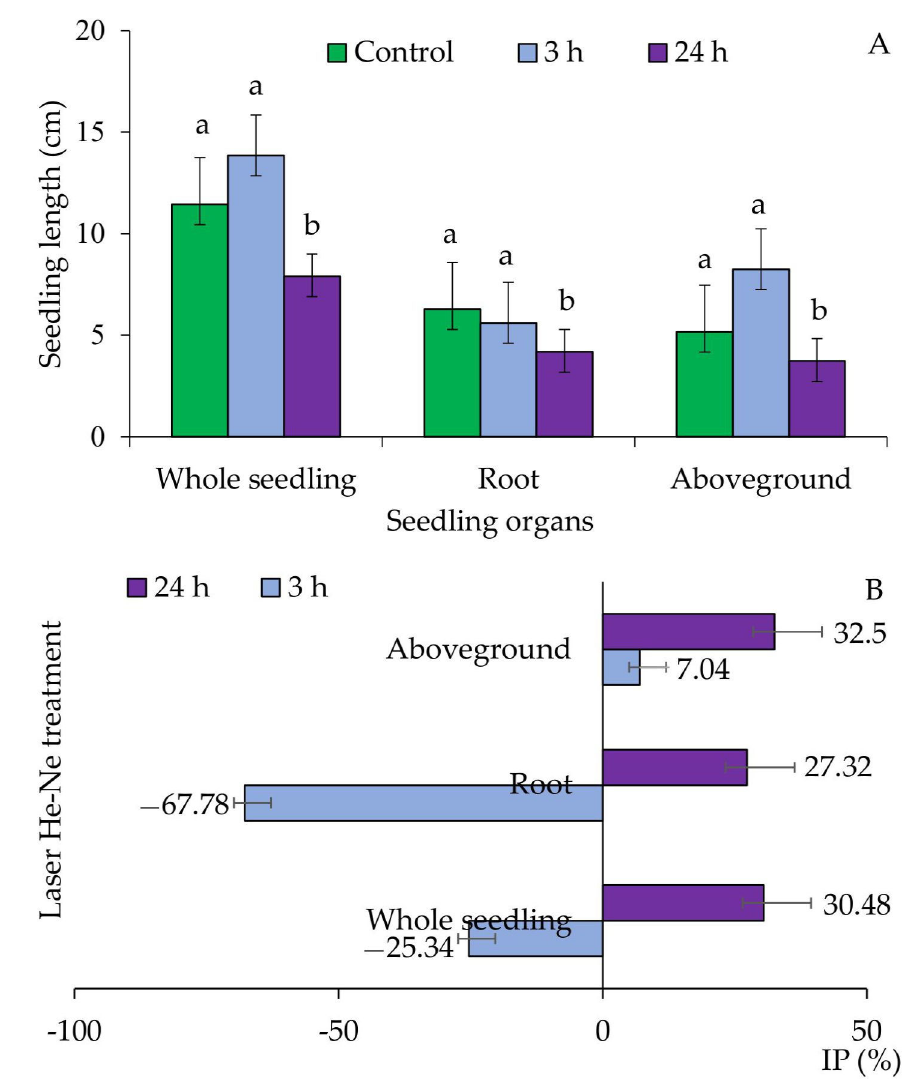
Figure 1. Length of triticale ( × Triticosecale Wittm. ex A.Camus) seedlings ( A ) and IP—inhibition percentage of growth (expressed as % of control) ( B ) irradiated with a helium-neon (He-Ne) laser by 3 and 24 h; ( A ) mean ± SD (n = 10) values marked with di ff erent letters di ff er statistically according to Tukey’s test at p ≤ 0.05; ( B ) minus (–) values of IP indicates growth stimulation, and plus ( + ) values of IP indicates growth